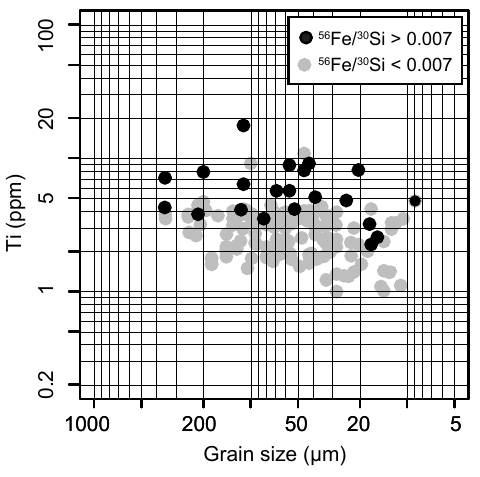
Figure 2. Plot of grain size vs. Ti showing all analyses where Fe was measured. Analyses with high Fe contents ( 56 Fe / 30 Si ratios > 0 . 007) are plotted in black. The coincidence of high Fe / Si ratios with high Ti suggests that the high-Ti analyses were contaminated by some non-quartz phase, possibly Fe–Ti oxides, which are com- mon in the Alpine Fault mylonites. All analyses with 56 Fe / 30 Si ra- tios > 0 . 007 or Ti concentrations > 5ppm were removed from the dataset (see text for